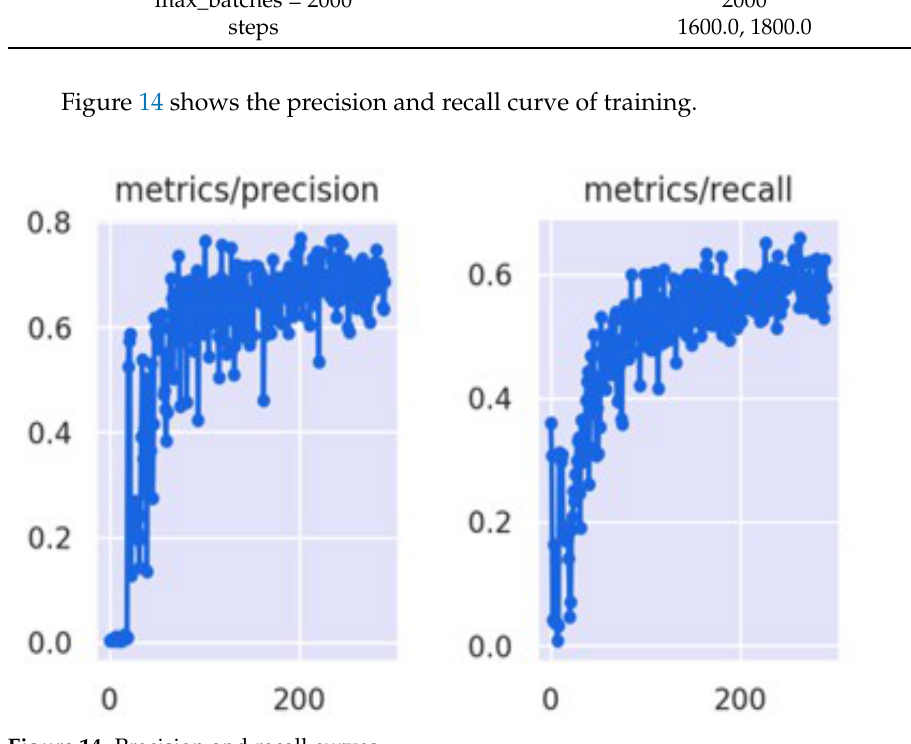
Figure 14. Precision and recall curves.